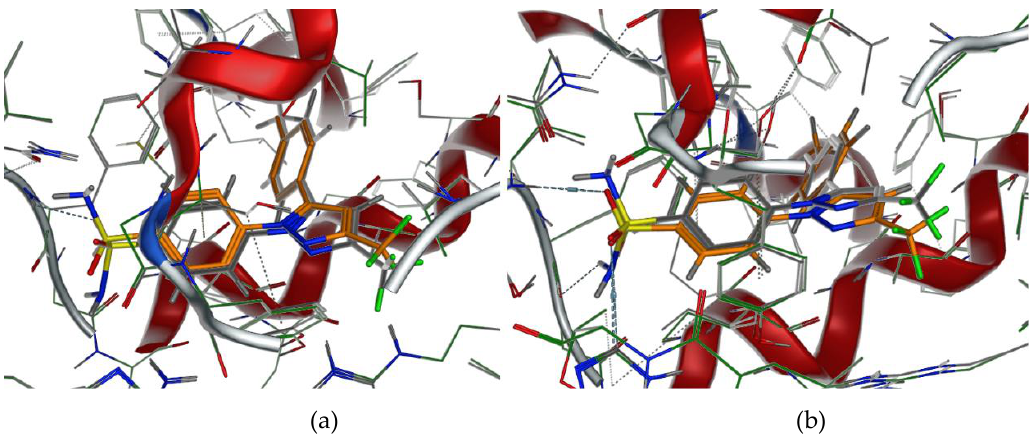
Figure 7. Internal validation of the developed model. The most adequate conformation generated for celecoxib (gray) as compared to the template location (RSA data, orange): h COX-2: Free binding energy: − 14.27 kcal/mol ( a ); h COX-1: Free binding energy: − 13.39 kcal/mol ( b ); RMSD = 0.13 and 0.21, respectively.